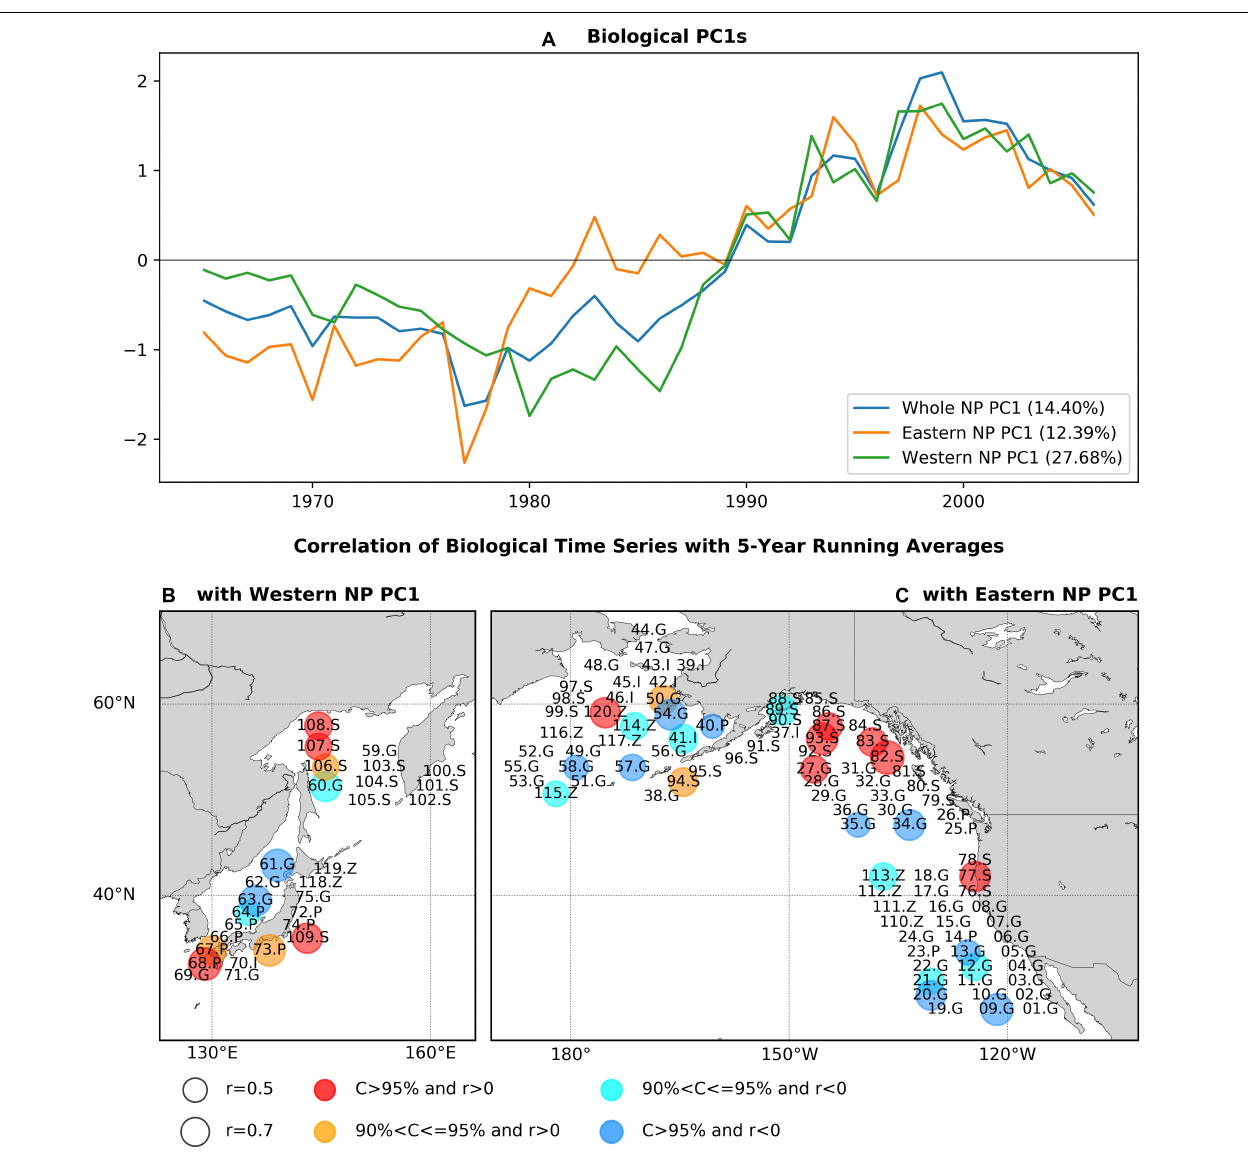
FIGURE 2 | (A) PC1s for the whole NP, eastern NP, and western NP marine biological time series, and statistically significant correlations of marine biological time series (B) with the western NP PC1, (C) with the eastern NP PC1. Before calculating correlations 5-year running means are applied to PC1s and marine biological time series. In (B,C) , numbers indicate species ID in Supplementary Table 1 , while S, G, P, Z, and I indicate salmon, groundfish, small-pelagic, zooplankton, and invertebrate, respectively. Circle size indicates the absolute values of correlations and colors of the circles (red, orange, cyan, blue) indicate the sign of correlations and the corresponding confidence